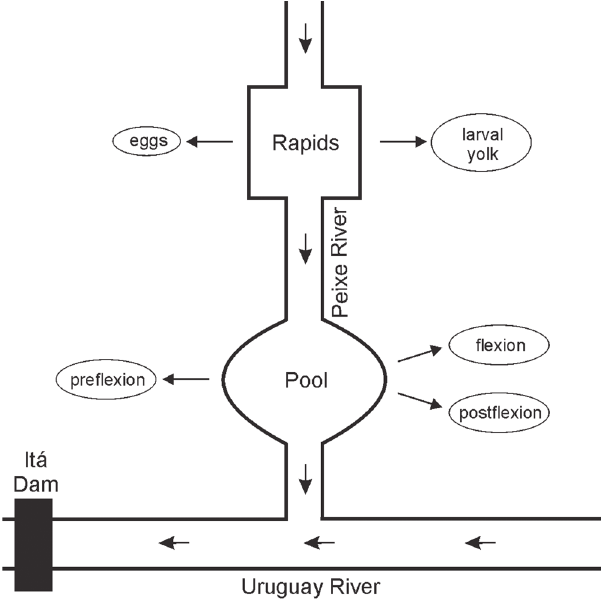
Fig. 11. Conceptual model of the distribution patterns of eggs and larvae in the early stages of two environments in the Peixe River (upper Uruguay River), from October 2011 to March